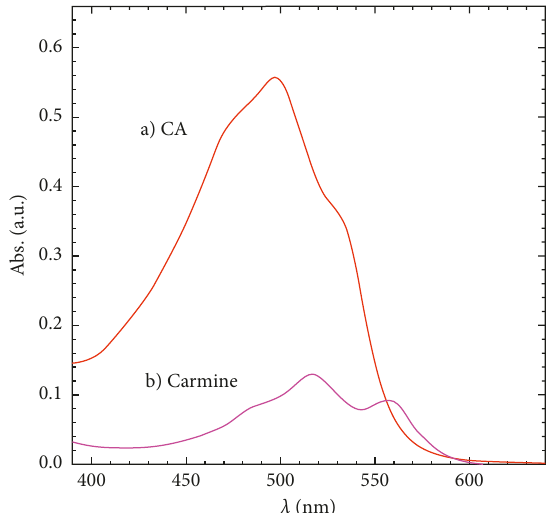
Figure 7: Optical absorbance curves of (a) CA and (b) carmine.